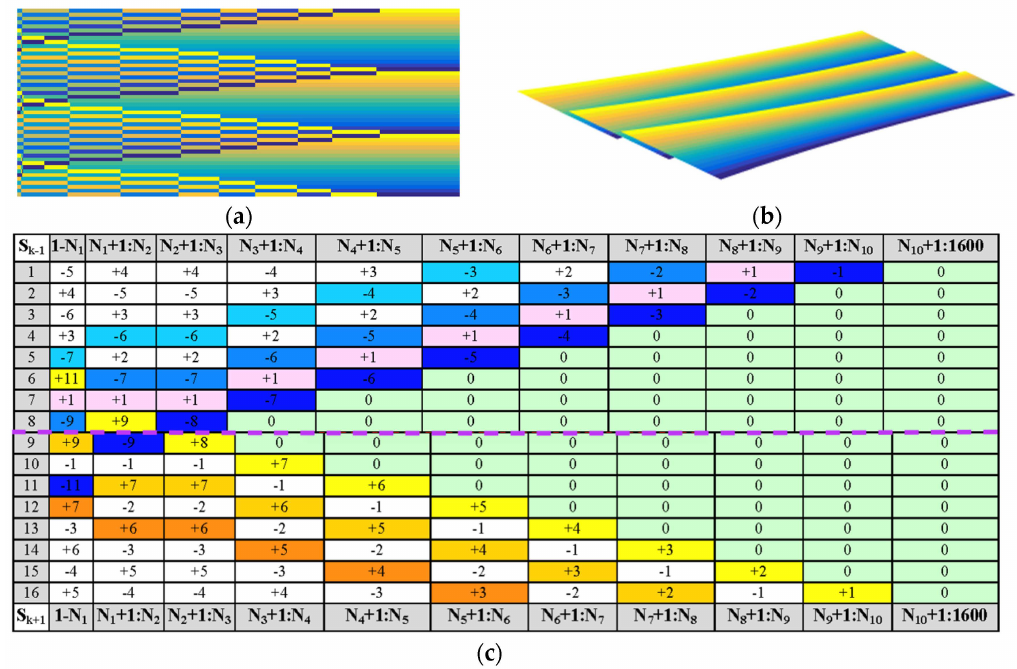
Figure 5. Three consecutive VIIRS whiskbrooms for the left half of the scan (from the edge of the swath to the nadir): ( a ) in swath projection (along with sorting patterns); ( b ) in the mapped projection. The detectors are shown with distinct colors ranging from yellow (detector 1) to blue (detector 16); and ( c ) reordering scheme corresponding to the left half of the VIIRS swath. The top and bottom halves of the reordering table are displaced intentionally, to emphasize that the corresponding sorting patterns may be different (see text for